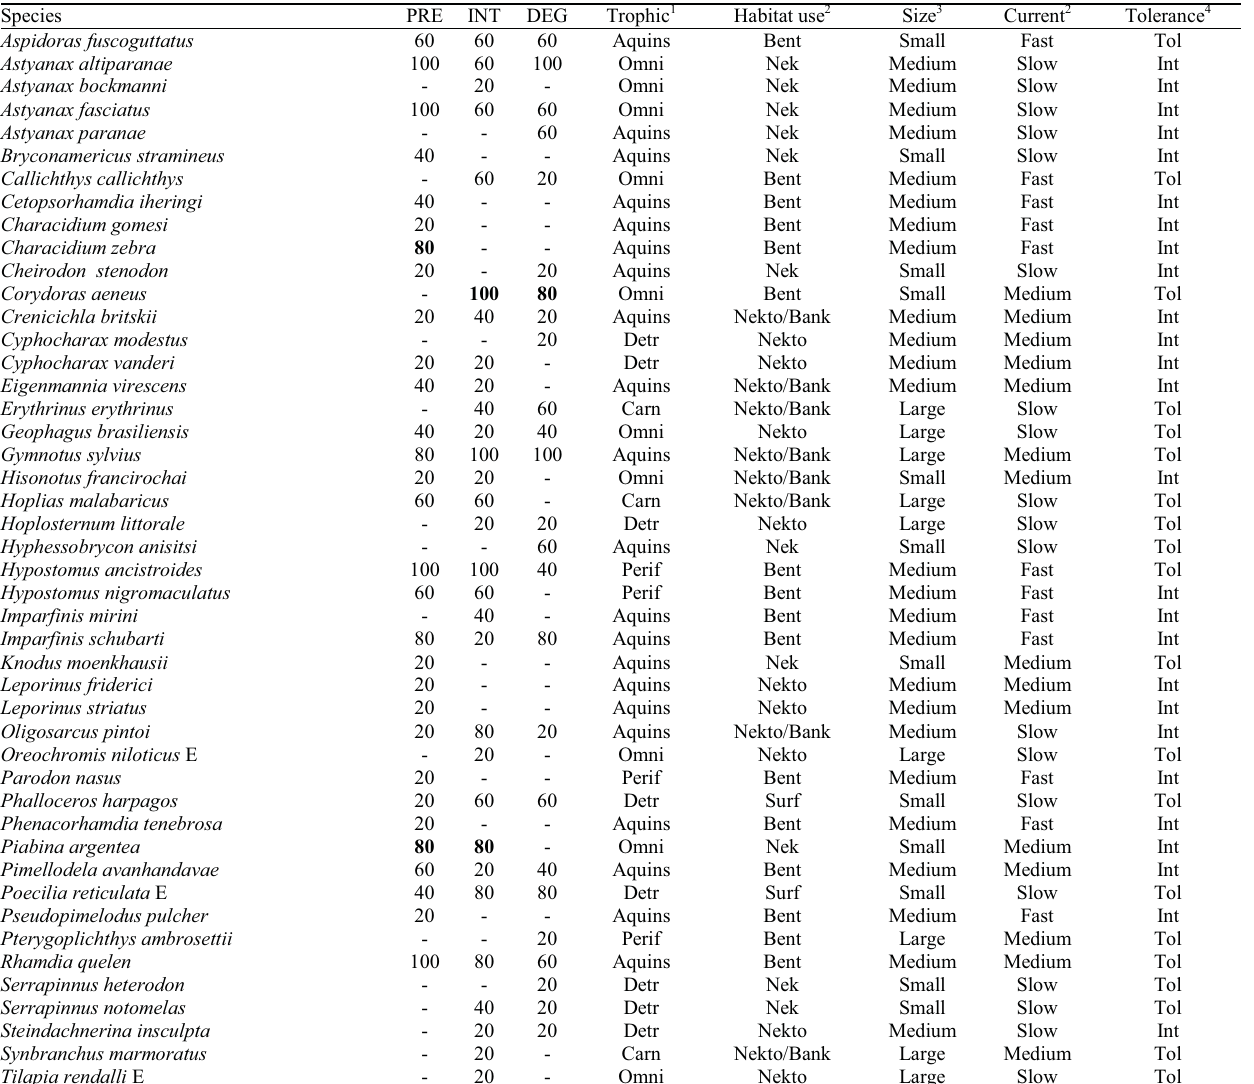
Table 2. Collected species, frequency of occurrence in each stream group (PRE, preserved; INT, intermediate; DEG, degraded). E = following species name indicates exotic species. Values marked in bold indicate the habitat or combination of habitats where species were significantly associated, according to IndVal analysis. Species features included: trophic group (Aquins, insectivores with predominance of aquatic forms; Carn, carnivores with predominance of invertebrates and fishes; Detr, detritivores; Omni, omnivores; Perif, periphytivores), habitat use (Bent, benthic; Nek, nektonics; Nekto, nektobenthic; Nekto/ Bank, nektobenthic associated with stream banks; Surf, close to the surface of the water), size (Small, < 50 mm; Medium, 50- 150 mm; Large, > 150 mm), preference for current (arbitrarily classified in Slow; Medium; Fast) and hypoxia tolerance (Tol, tolerant; Int, intolerant). 1 Andrian et al . (1994), Castro & Casatti (1997), Uieda et al . (1997), Gibran et al . (2001), Casatti (2002), Ferreira & Casatti (2006) and Rocha et al . (2009). 2 Casatti & Castro (1998), Casatti et al . (2001), Casatti (2002) and